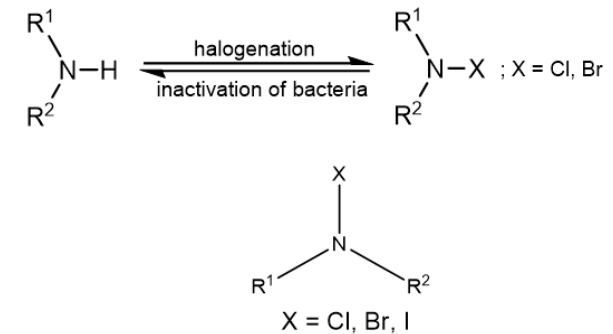
Figure 2. General chemical structure of an N -halamine.